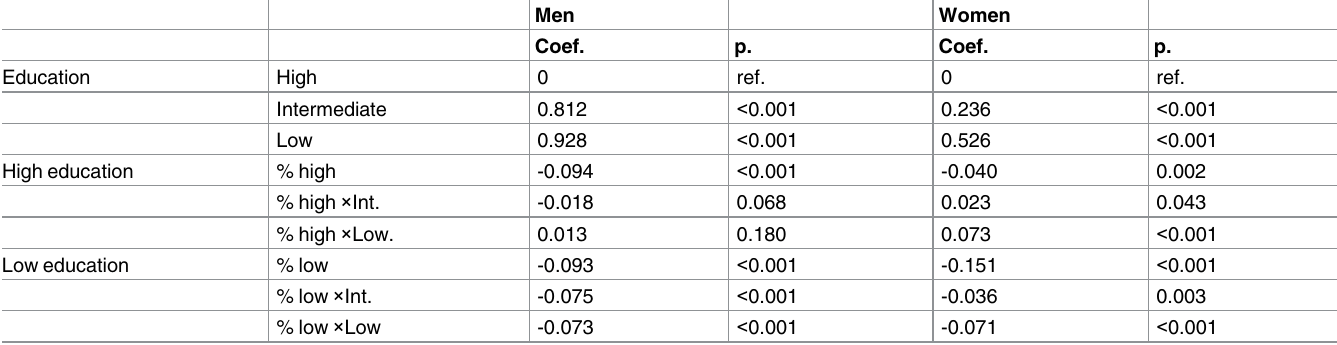
Table 3. The association between individual education, proportion of high and low educated and all-cause mortality for men and women, 30–84 yrs. Men Women Coef. p. Coef.